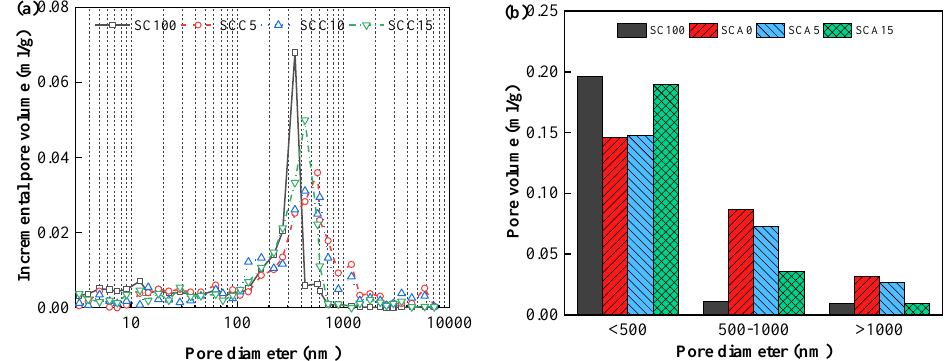
Figure 7. Pore size distribution results of hardened CPB with different doses of quicklime at the hydration time of 28 days: ( a ) the incremental pore volume, and ( b ) the volume of different pore types.